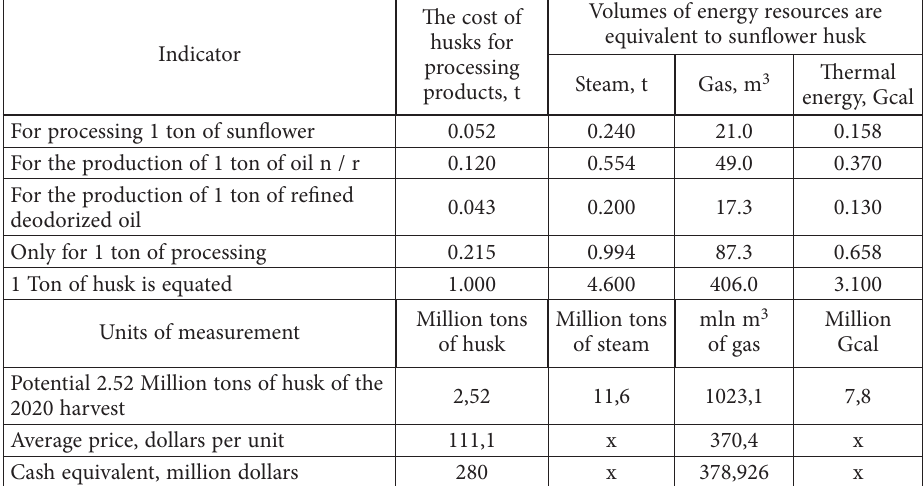
Table 2. Energy potential of sunflower husk and energy equivalents obtained from them and energy cost substitution equivalent in the oil and fat sector by sunflower husk (source: authors’ own calcula- tions based on Geletukha, 2021) Volumes of energy resources are The cost of equivalent to sunflower husk husks for Indicator processing Thermal Steam, t Gas, m 3 products, t energy, Gcal For processing 1 ton of sunflower 0.052 0.240 21.0 0.158 For the production of 1 ton of oil n / r 0.120 0.554 49.0 0.370 0.043